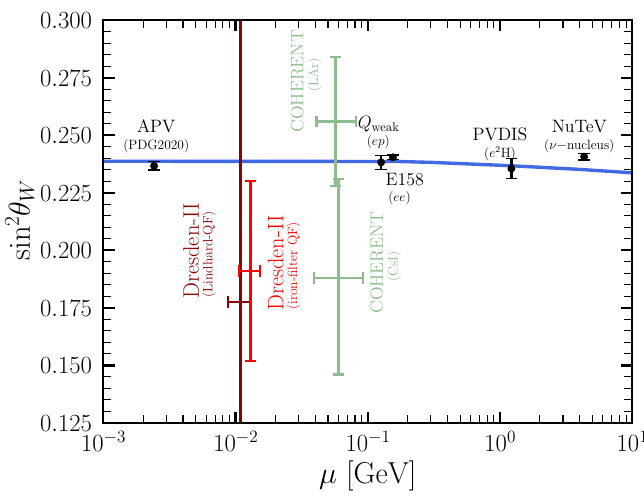
Figure 3 . Weak mixing angle RGE running in the SM, calculated in the MS renormalization scheme as obtained in ref. [96], along with measurements at different renormalization scales [1, 2, 90–95]. The 1 σ result obtained using the Dresden-II reactor data is shown assuming the modified Lindhard and iron-filter QF (see text for further